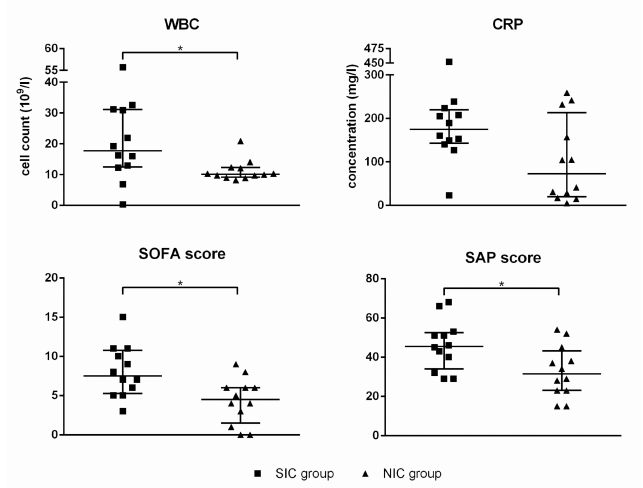
Figure 1. White blood cell count (WBC), serum level of C-reactive protein (CRP), the sequential organ failure assessment (SOFA) score, and the simplified acute physiology (SAP) score II were determined for every patient enrolled in the septic intensive care (SIC) and the non-septic intensive care (NIC) group. The blood sample was taken immediately after admission to the intensive care unit (ICU). Data are presented as median ± interquartile rande (IQR; n = 12); the asterisk denotes a significant ( p < 0.05) group di ff erence.